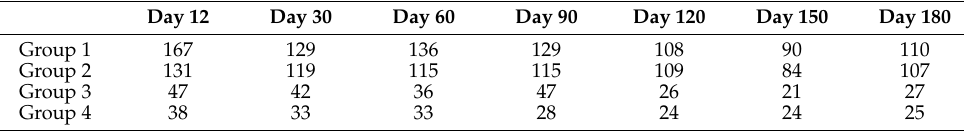
Data are presented as medians and